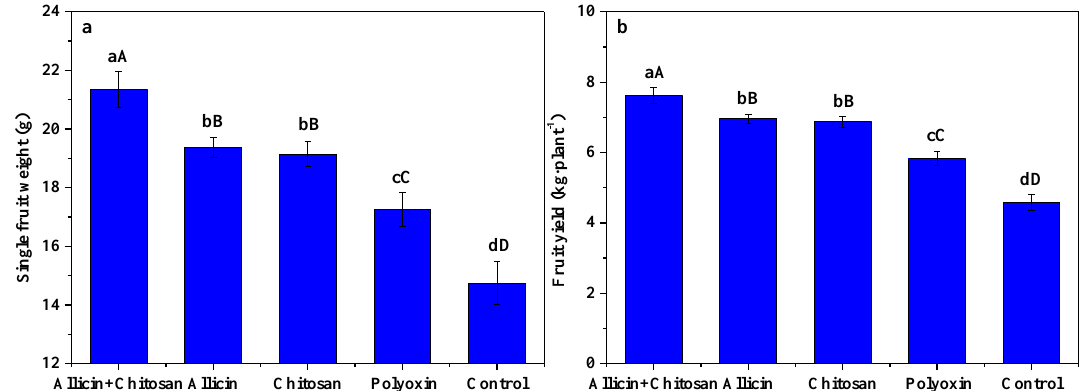
Figure 3. The effects of allicin and chitosan on single fruit weight ( a ) and fruit yield per plant ( b ) of R. roxburghii . Values and error bars indicate the mean and SD of three replicates, respectively. Different small letters indicate significant differences at 5% level ( p < 0.05), and different capital letters indicate significant differences at 1% level ( p < 0.01). Table 4. The effects of allicin and chitosan on quality of R. roxburghii